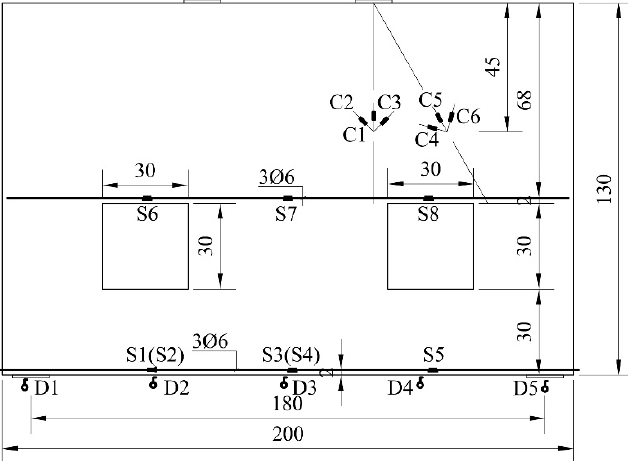
Figure 11. The arrangements of comparators for measuring deflection and strain gauges for specimen Figure11. ThearrangementsofcomparatorsformeasuringdeflectionandstraingaugesforspecimenW1. Appl. Sci. 2020 , 10 , x FOR PEER REVIEW W1.